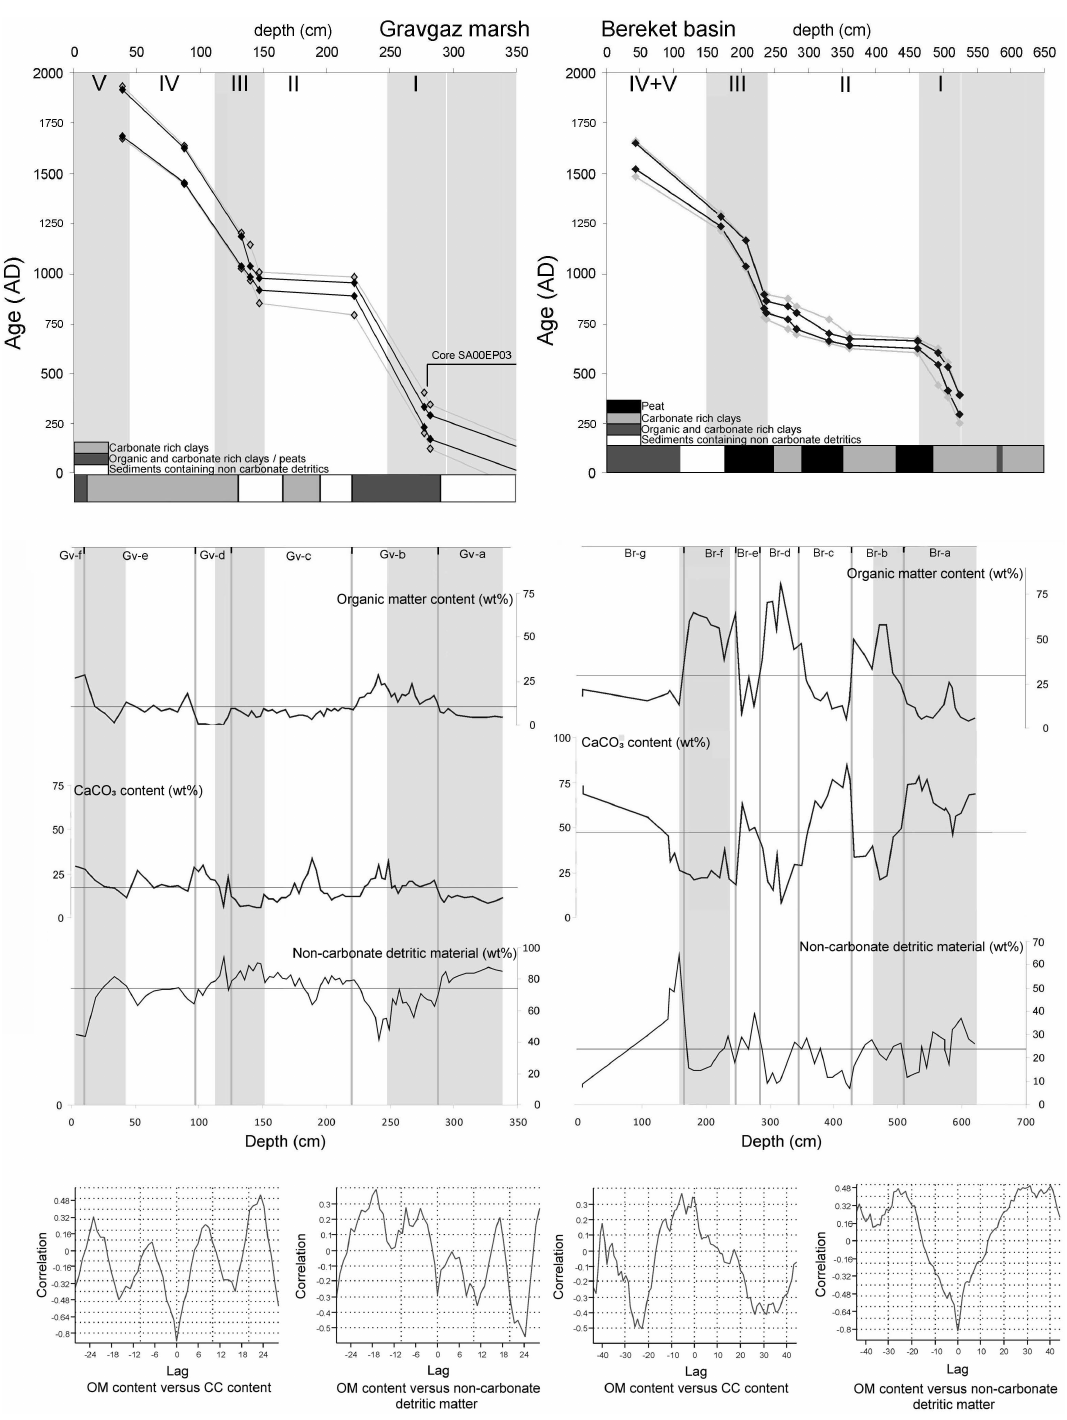
Fig. 3. Top: age-depth curves for Gravgaz core SA06EP1 (left) and Bereket SA09JBDrill01 (right). Middle: an overview of OM content, CC content, and pollen concentration and preservation. Bottom: correlograms displaying the correlation between OM content of the sediments versus CC content, and non-carbonate detritic matter content. Grey bars indicate a subdivision into bioclimatic periods (Bakker et al., 2012). I = Mid-3rd century – mid-7th century AD Wet Period and earlier. II = Mid-7th century – mid-10th century AD dry period. III = Mid-10th century – mid-13th century AD Wet Period. IV and V = Mid-13th century dry period until recent. The vertical lines in the middle graphs indicate the division of the sediment records into different sedimentological units (see Table